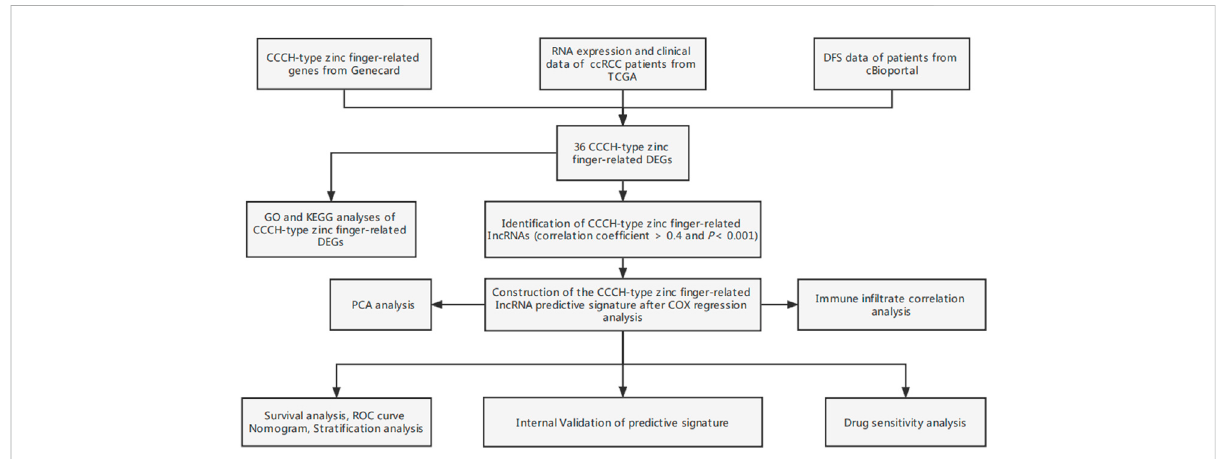
FIGURE 1 Study fl owchart.ccRCC,clearcellrenalcellcarcinoma;TCGA,CancerGenomeAtlas;DFS,disease-freesurvival;DEGs,differentiallyexpressed genes; GO, gene ontology; KEGG, Kyoto Encyclopedia of Genes and Genomes; lncRNAs, long-chain non-coding RNA; ROC, receiver operating characteristic; GSEA, gene enrichment analysis; ssGSEA, single-sample gene set enrichment